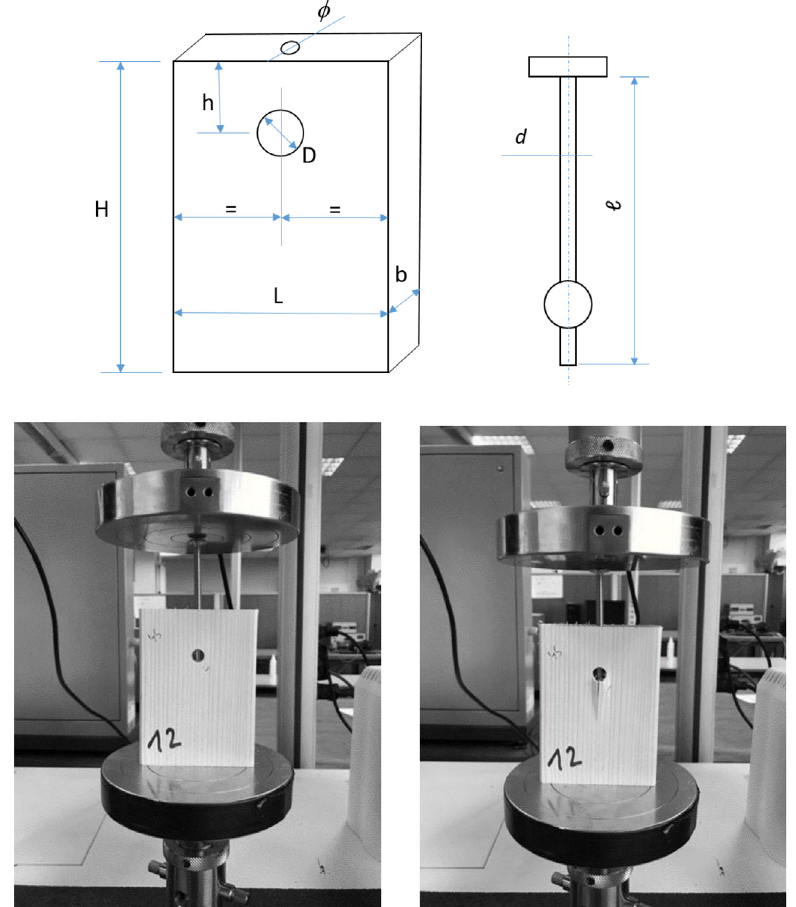
Fig. 2. (Top left) Geometry of the spruce specimens containing a horizontally centered circular through hole with diameter D and depth b (corresponding to the specimen depth), and a top circular non-through hole with diameter f and a depth of 55 mm. (Top right) Geometry of the screw with length ℓ and diameter d . (Bottom) Example of compression test performed on sample